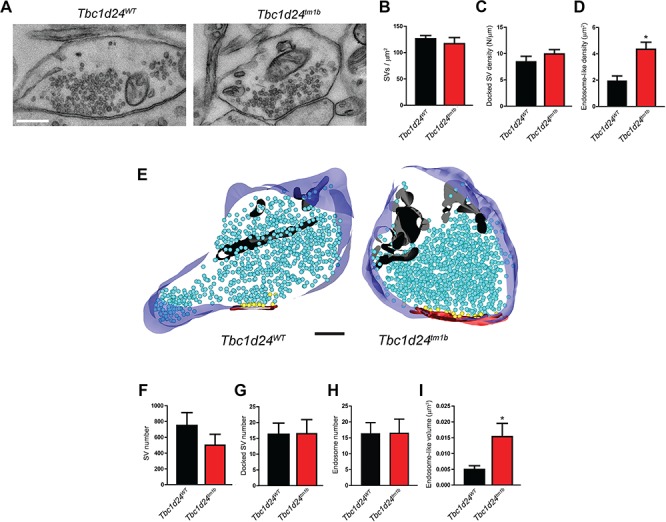
Genetic disruption of Tbc1d24 expression results in increased endosomal volume in primary neurons. (A) Representative TEM images of synapses of cultured cortical neurons from WT Tbc1d24WT and mutant Tbc1d24tm1b mice, fixed at 17 DIV. Scale bar: 200 nm. (B–D) Conventional TEM analysis of nerve terminals from Tbc1d24tm1b (red bars) revealed a preserved density of both total (H) and docked (I) SVs with respect to control neurons (black bars), with a significant increase in the density of endosomal-like structures. (E) Three-dimensional reconstructions of synaptic terminals from serial ultrathin sections; shown are representative three-dimensional reconstructions from 60 nm-thick serial sections obtained WT Tbc1d24WT and mutant Tbc1d24tm1b synapses. Total SVs and SVs physically docked at the AZ are depicted as blue and yellow spheres, respectively. The AZ and endosomes are shown in red and black, respectively. Scale bar, 200 nm. (F–H) Ultrastructural morphometric analysis of three-dimensionally reconstructed synapses displayed similar amount of both total (F) and docked (G) SVs and endosomal number (H). (I) The endosomal-like volume was calculated from each 2D analysis of synaptic profile and is expressed as mean ± SEM area of endosomes per μm3. Nerve terminal areas and AZ lengths were similar in the two experimental groups (N = 105 and 126 synapses for Tbc1d24WT and Tbc1d24tm1b, respectively, from three independent preparations). Data are expressed as the mean ± SEM. (D, I) *P < 0.05; Mann–Whitney test.